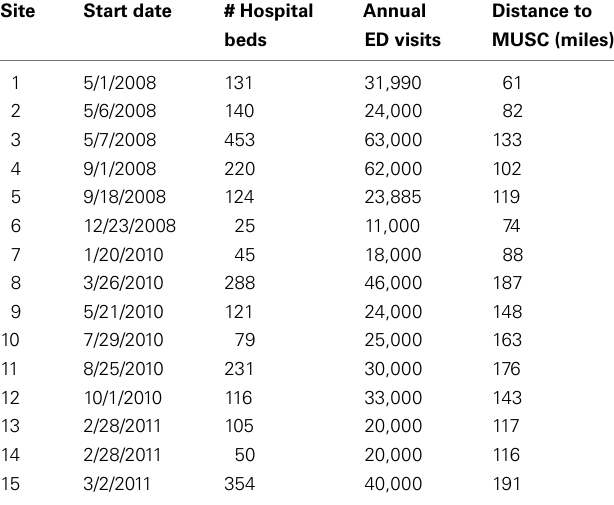
Table 1 | REACH MUSC network information.